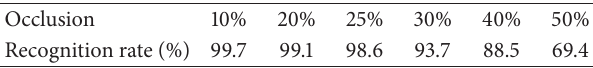
Table 3: Recognition rate under different levels of